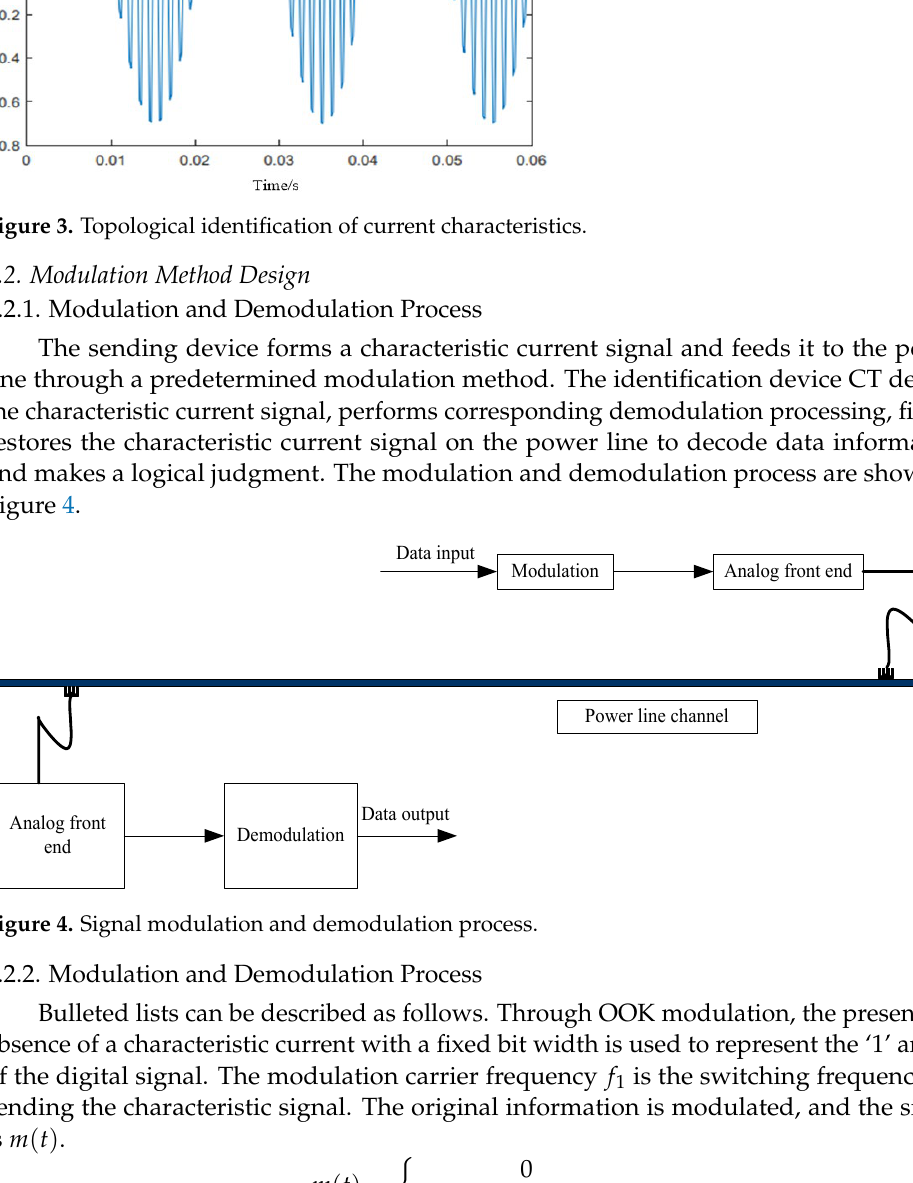
Figure 3. Topological identification of current characteristics.